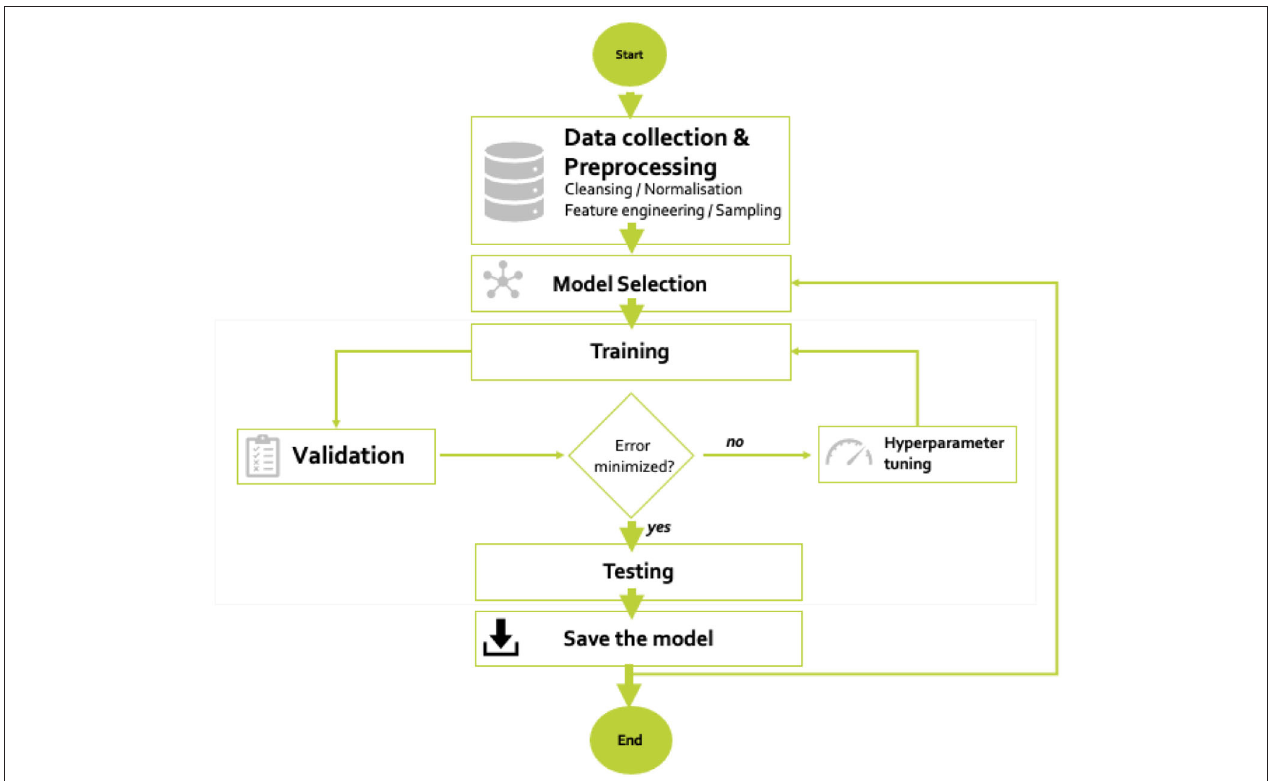
FIGURE 2 | Flow diagram of the development process of the data-driven photovoltaic (PV) power forecasting